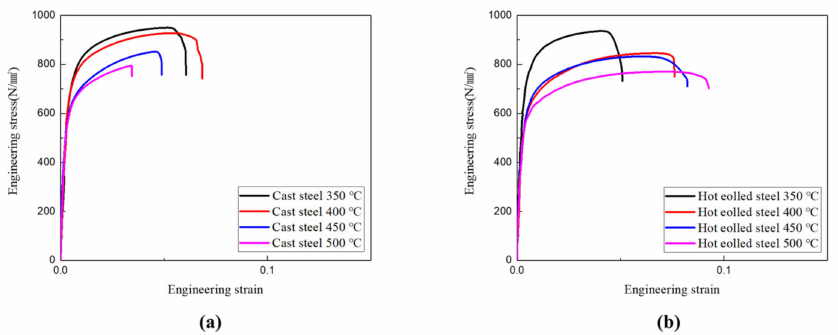
Figure 11. Strain–stress curves of ( a ) cast and ( b ) hot-rolled medium-carbon low-alloy steel after isothermal heat treatment.